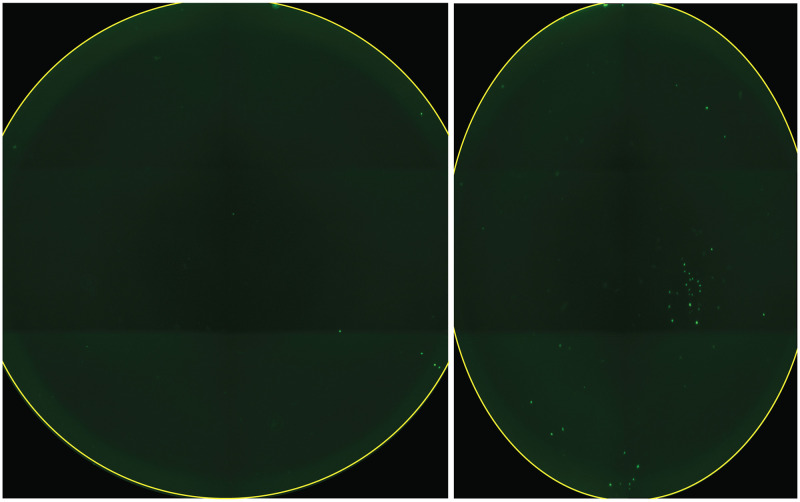
Compression error caused by software settings.On left, an image of a 96-well produced by EVOS. On right, a saved image of a well (from the same plate/scan) that has compressed the well into an ovoid shape. This problem was corrected by increasing the computer’s virtual memory allocation.